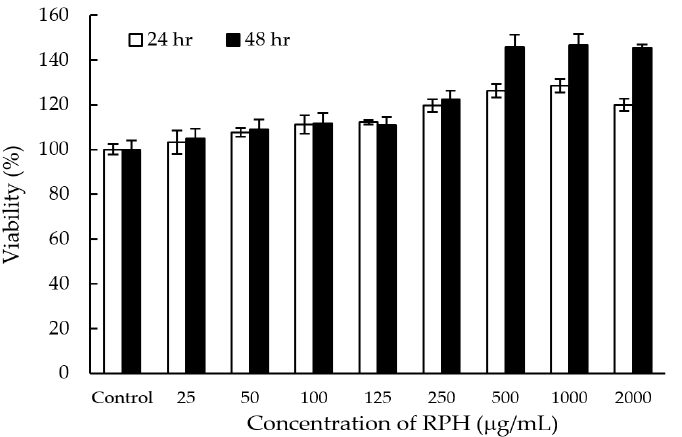
Figure 9. MTT assay for the cell toxicity of raw 264.7 cells treated with different RPH concentrations for 24 and 48 hrs.